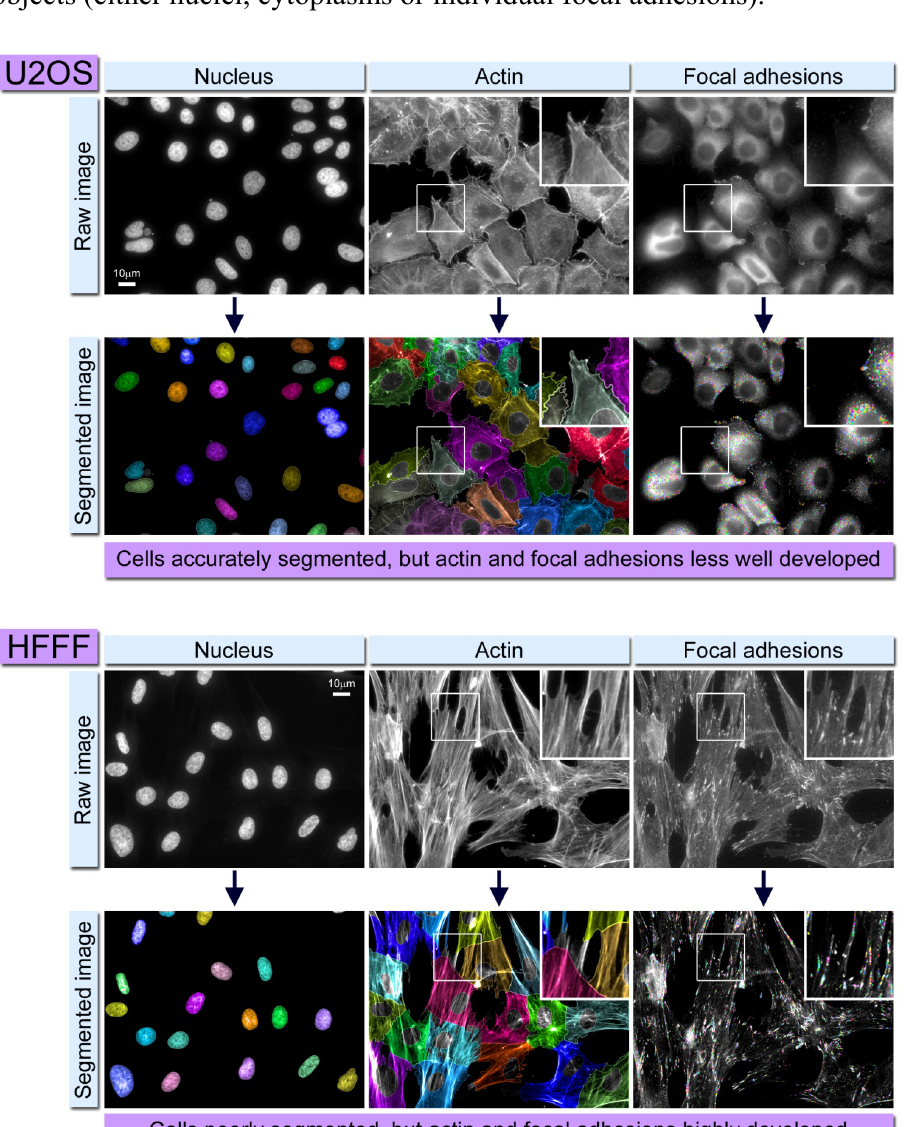
Figure 2. Example of problems that can arise during automated image analysis of cytoskeletal structures. Upper panel shows U2OS osteosarcoma cells fluorescently labeled for actin and focal adhesions. The cytoplasm of each individual cell (shown in the actin channels) is accurately segmented; however the focal adhesions are small and not prominent, therefore resulting in their poor detection (and therefore quantification) by the software. The lower panel shows HFFF (human fetal foreskin fibroblast) cells treated the same way as above. These particular cells have a well-developed cytoskeleton, and the focal adhesions are accurately identified. However as the peripheries of these cells grow over one another, their individual cytoplasms (and therefore cells) are often segmented incorrectly. In the processed (segmented) images the color coding is simply used to denote distinct objects (either nuclei, cytoplasms or individual focal